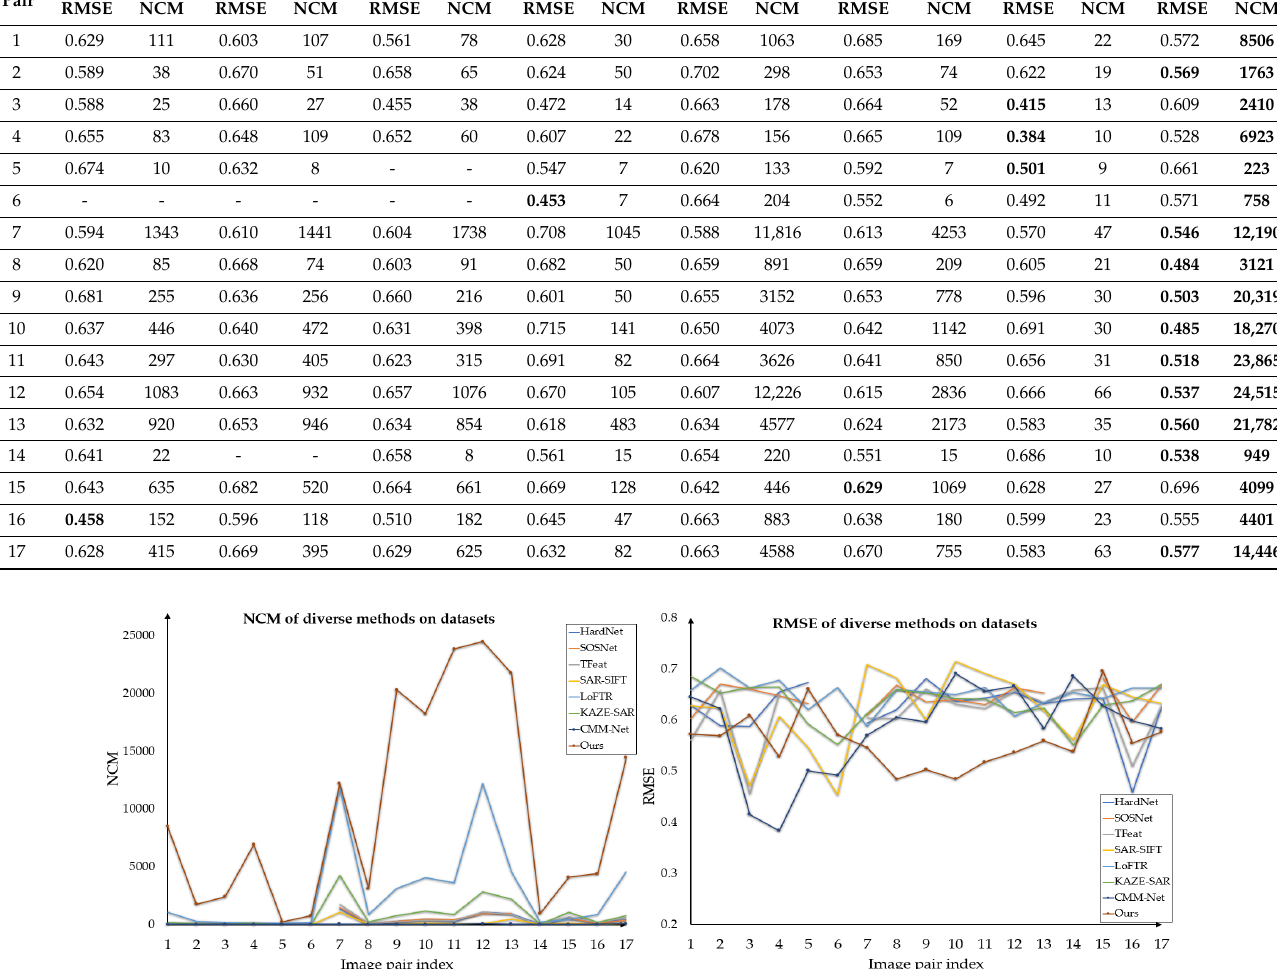
Table 2. RMSE and NCM of diverse methods on the datasets.